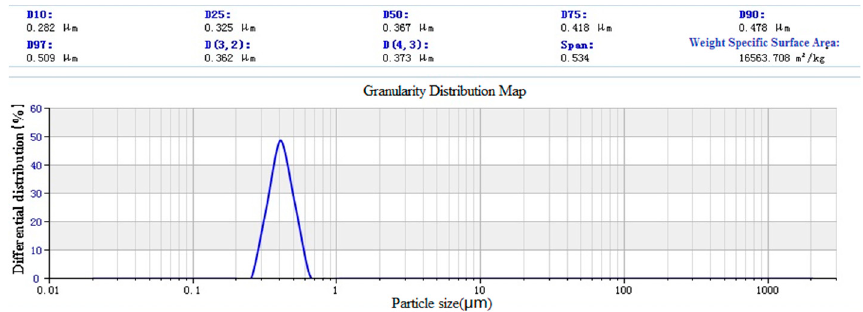
Figure 15. Paraffin @ Nano-SiO 2 Laser Particle Size Analysis Diagram.